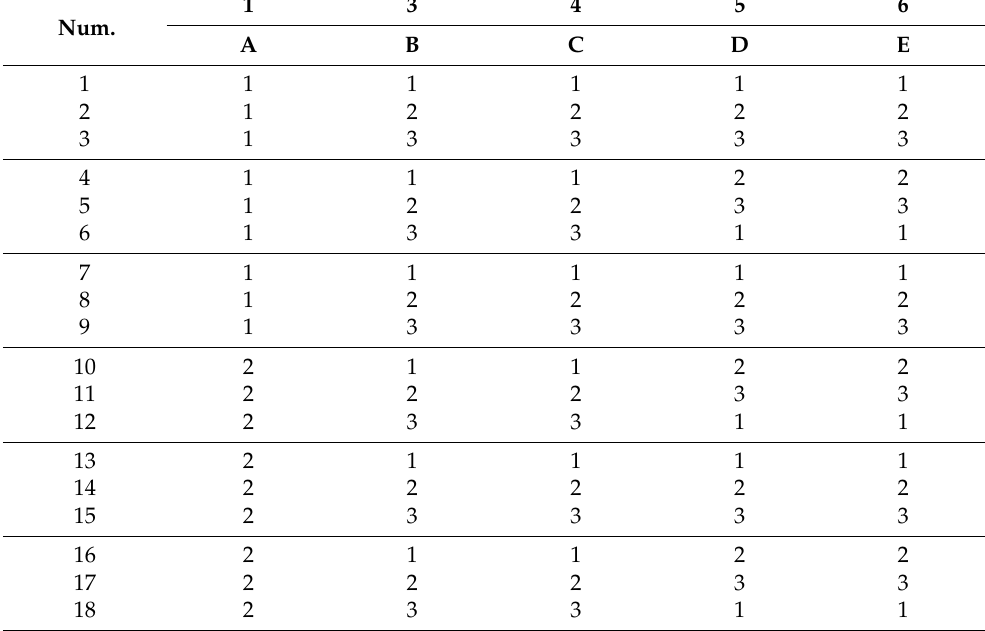
Table 3. Information of the 18 experiments.